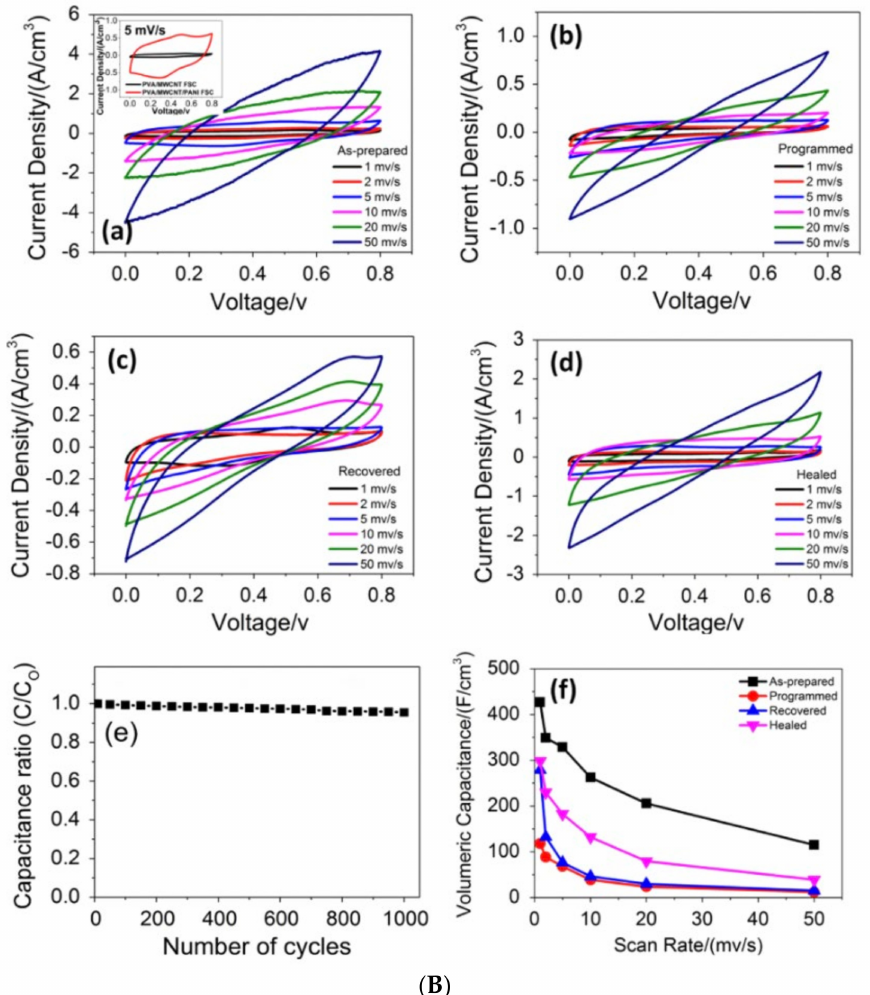
Figure 24. ( A ) Schematics of the fabrication process for a full shape memory polymer fiber SC (F–SMPFSC). ( B ) Electrochemical performance of solid-state F–SMPFSC at different shape memory